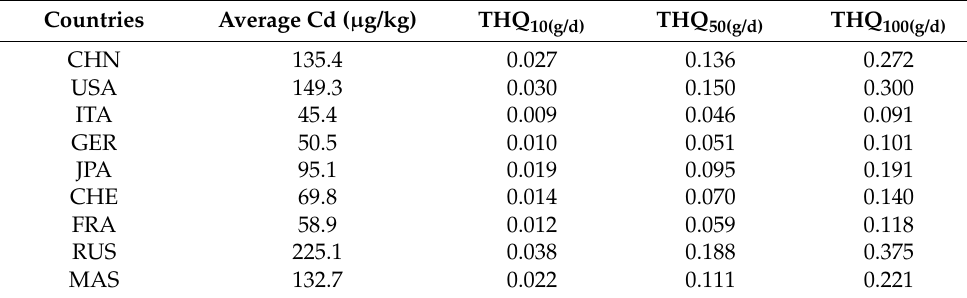
Table 2. Health risk assessment of chocolate Cd intake for Chinese